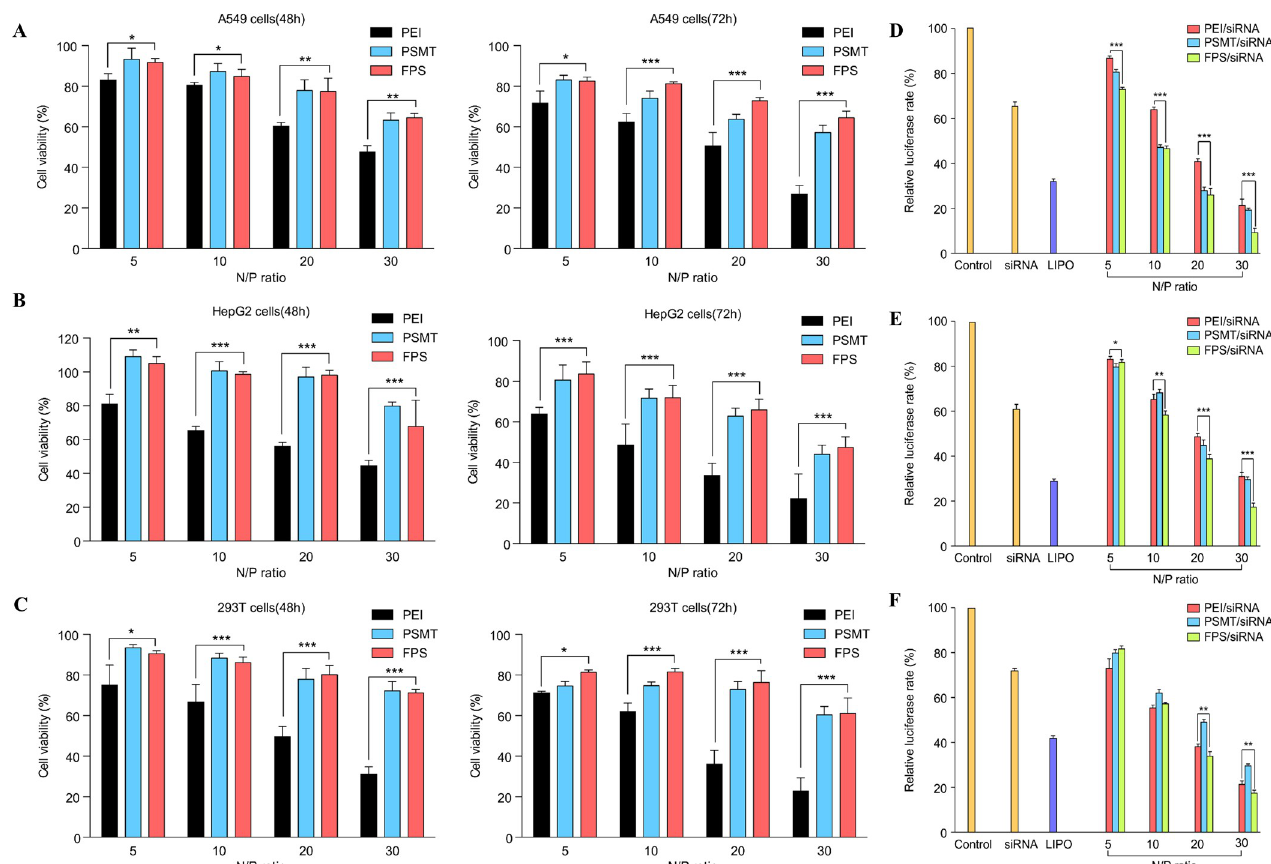
Fig 2. Cytotoxicity of PEI/siRNA complexes. PSMT/siRNA complexes, and FPS/siRNA complexes was measured by MTT assay in A; A549 cells, B; HepG2 cells, and C; 293T cells after 48h and 72h. [ n = 5, one-way ANOVA, � p < 0.1; �� p < 0.05; ��� p < 0.01, compared to that of FPS/siRNA complexes with control (PEI)]. D-F; PEI, PSMT, FPS and Lipofectamine 2000 were complexed with luciferase siRNA at various N/P ratios and transfected in (D) A549 cells, (E) HepG2 cells, and (F) 293T cells without serum. Chemo-luminescence was measured 48h after transfection and normalized with the amount of protein. [ n = 5, one-way ANOVA; � p < 0.1; �� p < 0.05; ��� p < 0.01; compared to that of FPS/siRNA complexes and control groups].